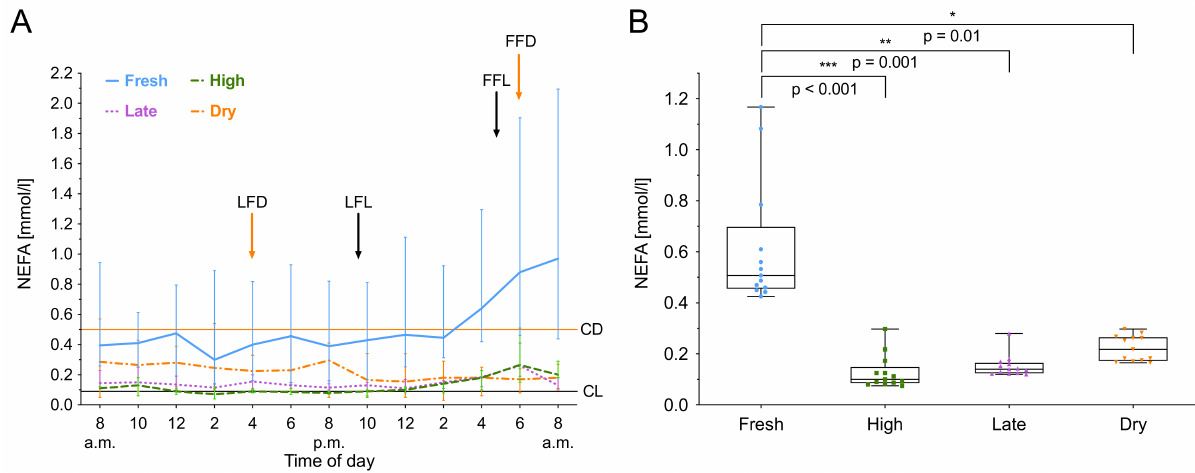
Figure 1. Non-esterified fatty acids (NEFA) concentration in serum over 24 h. ( A ) Data expressed as group median with the interquartile range as error bars. Last and first feeding of the day and cut off levels for group investigations [9] are shown. Black color indicates lactating cows, orange represents dry cows. LFL: last feeding of lactating cows; FFL: first feeding of lactating cows; LFD: last feeding of dry cows; FFD: first feeding of dry cows; CL: Cut off level of lactating cows; CD: Cut off level of dry cows. ( B ) Within-group distribution of NEFA concentration in serum over 24 h. The box depicts the mean and the lower and upper quartile. The whiskers show minimum and maximum values. Brackets represent Tukey adjusted pairwise comparisons between lactation group